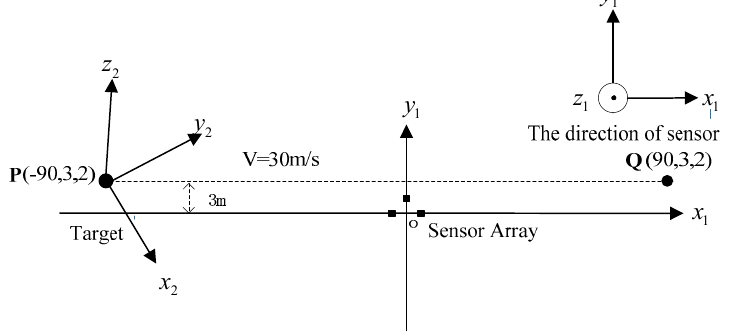
Figure 4. The overhead view of three noncollinear magnetic sensors.